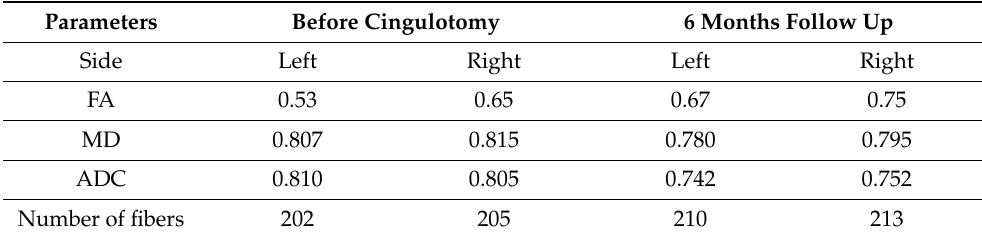
Table 2. The patient’s morphological data of the arcuate fascicles before cingulotomy and 6 months follow